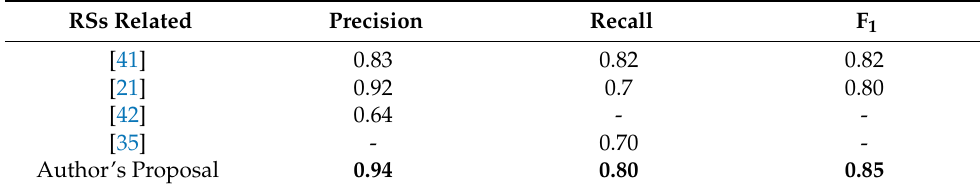
Table 10. Comparison of evaluation metrics in similar work.